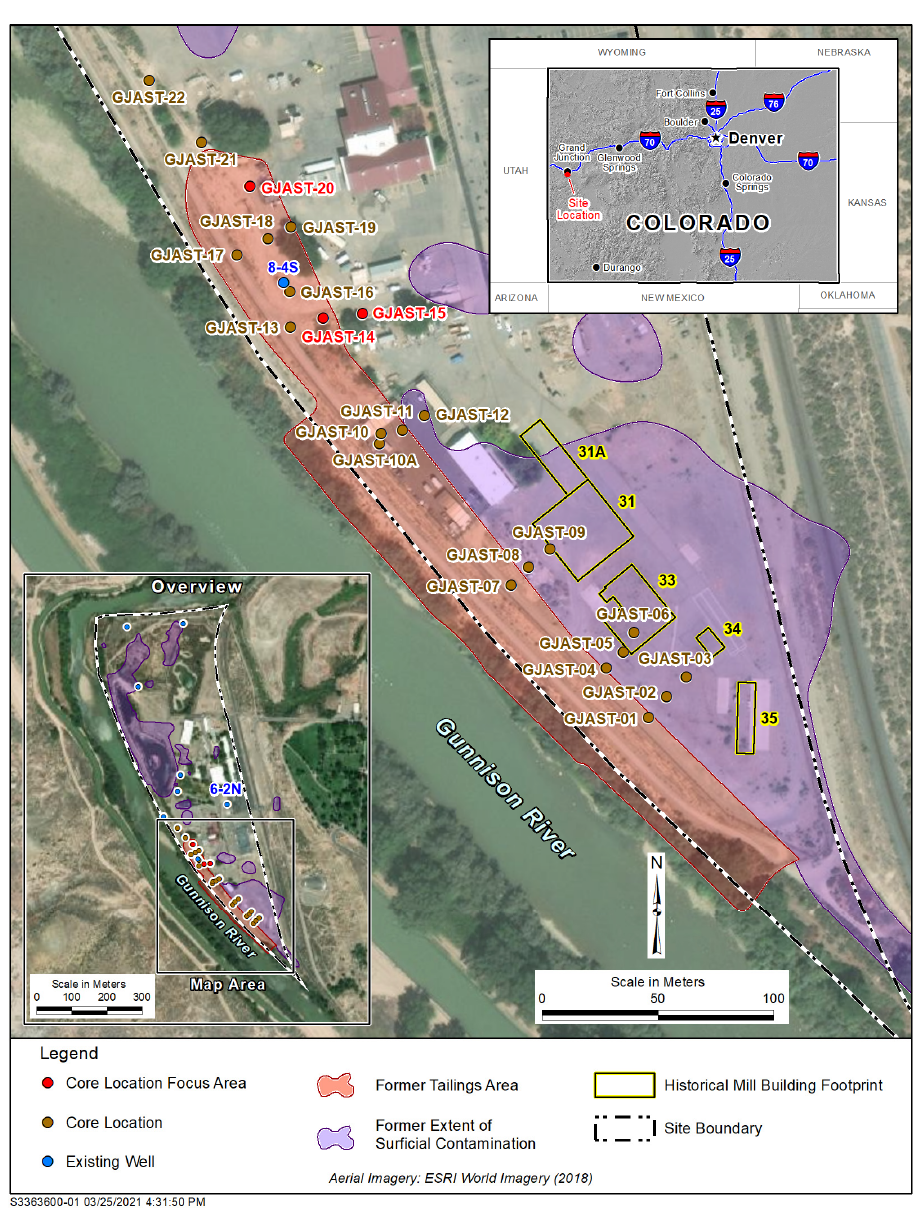
Figure 1. GJO site with coring locations, existing wells, and former contamination areas. River is flowing northward, and the side channel is an irrigation ditch.